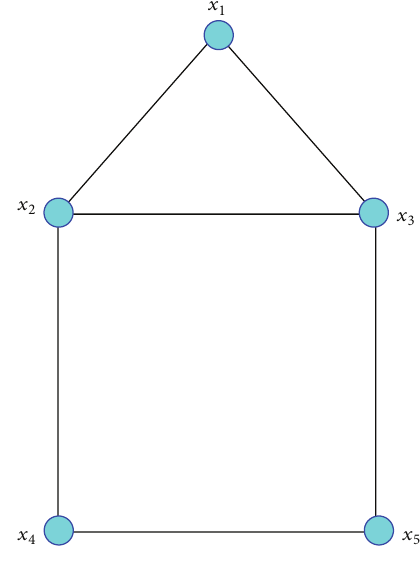
Figure 1: The graph for Lemma